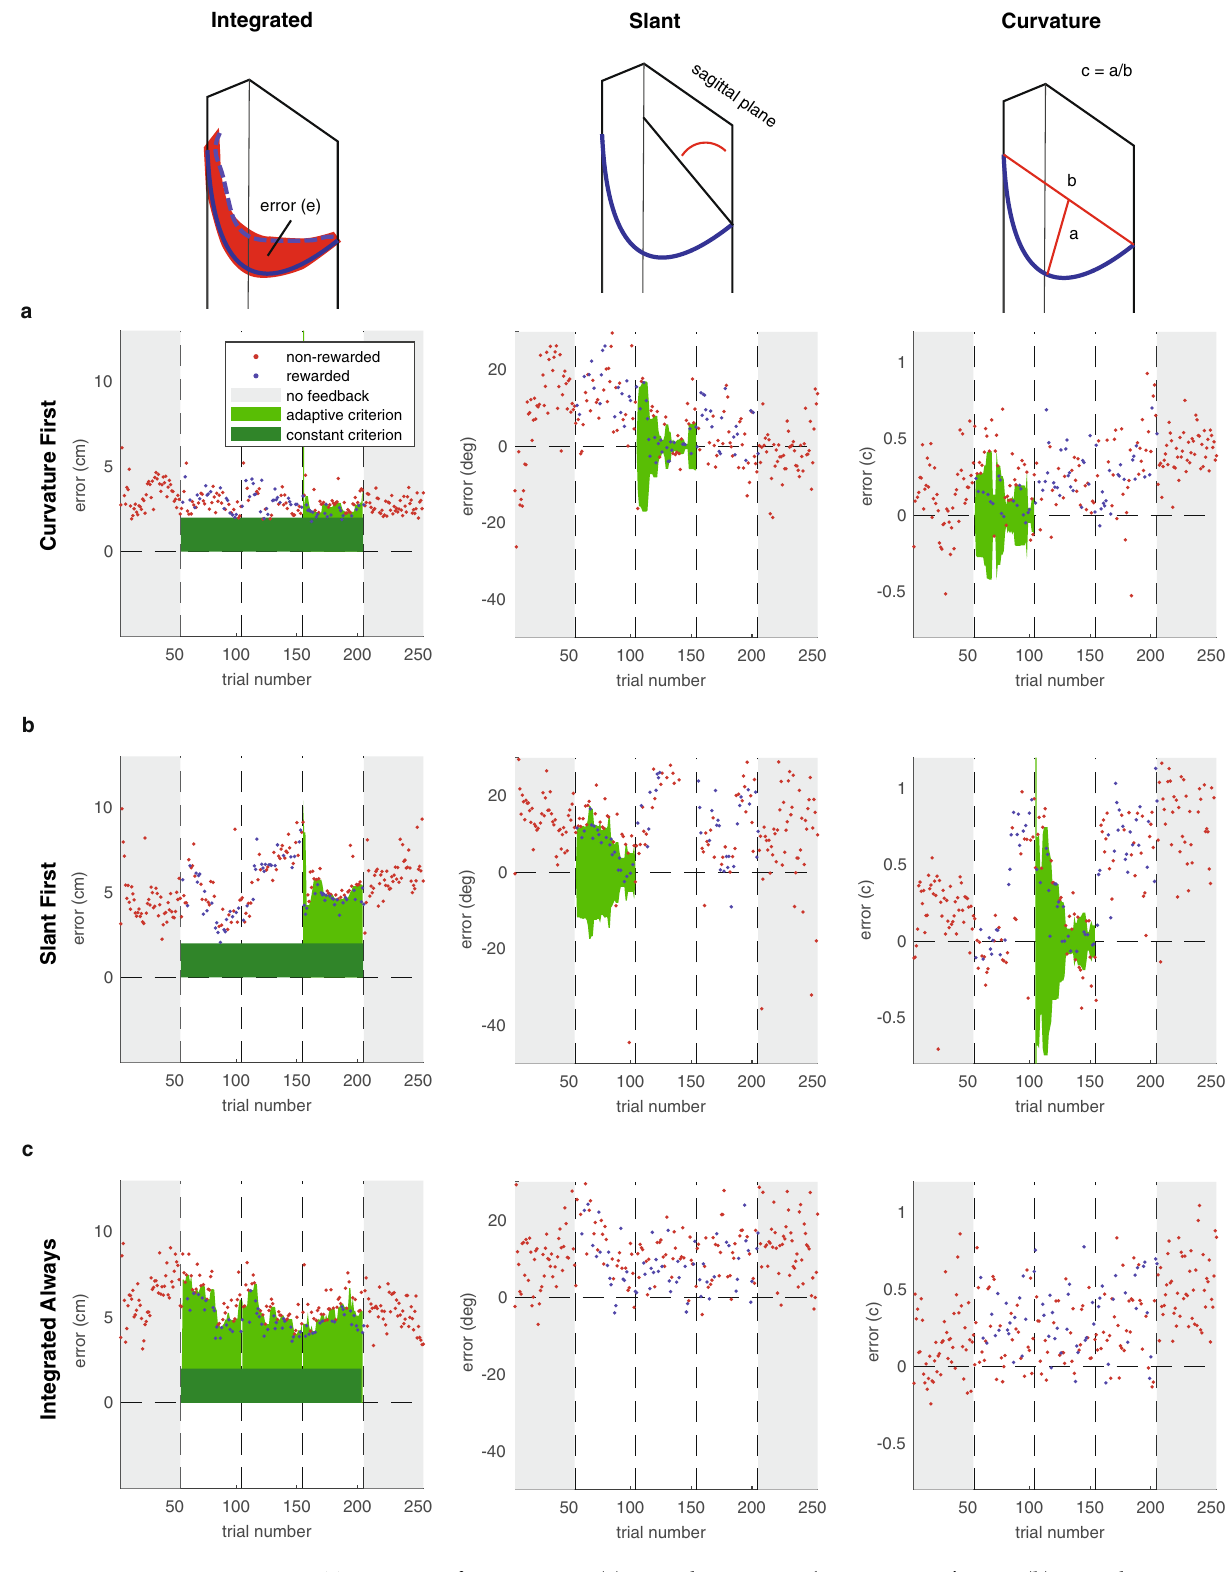
Figure 5. Time-course of Experiment 2. ( a ) Example participant ‘Curvature First’ group. ( b ) Example participant ‘Slant First’ group. ( c ) Example participant ‘Integrated Always’ group. ( a–c ) Left panel: integrated error; middle panel: slant error; right panel: curvature error. The green shaded areas represent the reward criteria that were applied in each